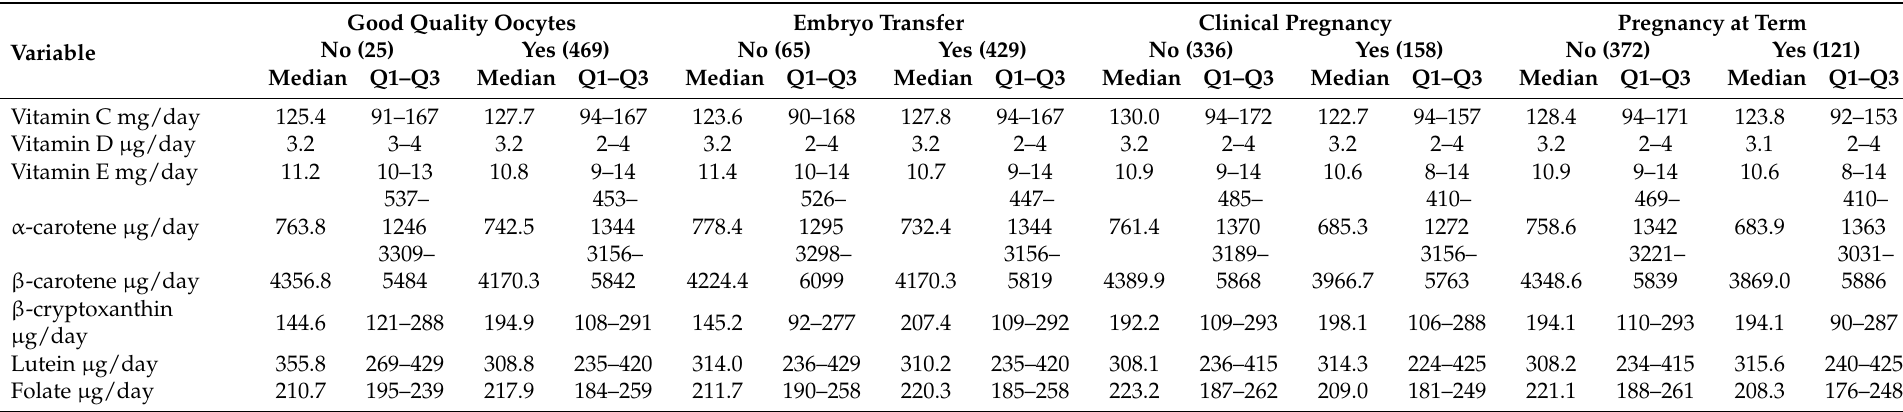
Table 2. Antioxidant and micronutrient intake of 494 women according to IVF outcomes.